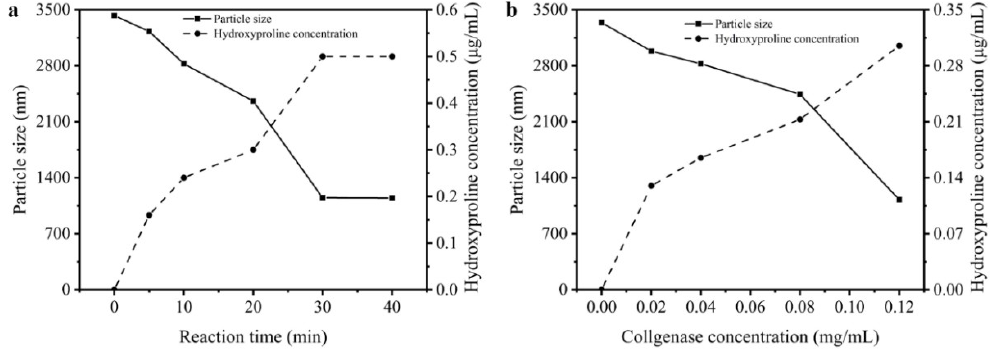
Figure 5. The changes in particle sizes and hydroxyproline in the solution. ( a ) Dissociation influenced by different reaction time (0, 5, 10, 20, 30, 40 min). ( b ) Dissociation influenced by different concentration of collagenase I (0, 0.02, 0.04, 0.08, 0.12 mg/mL).